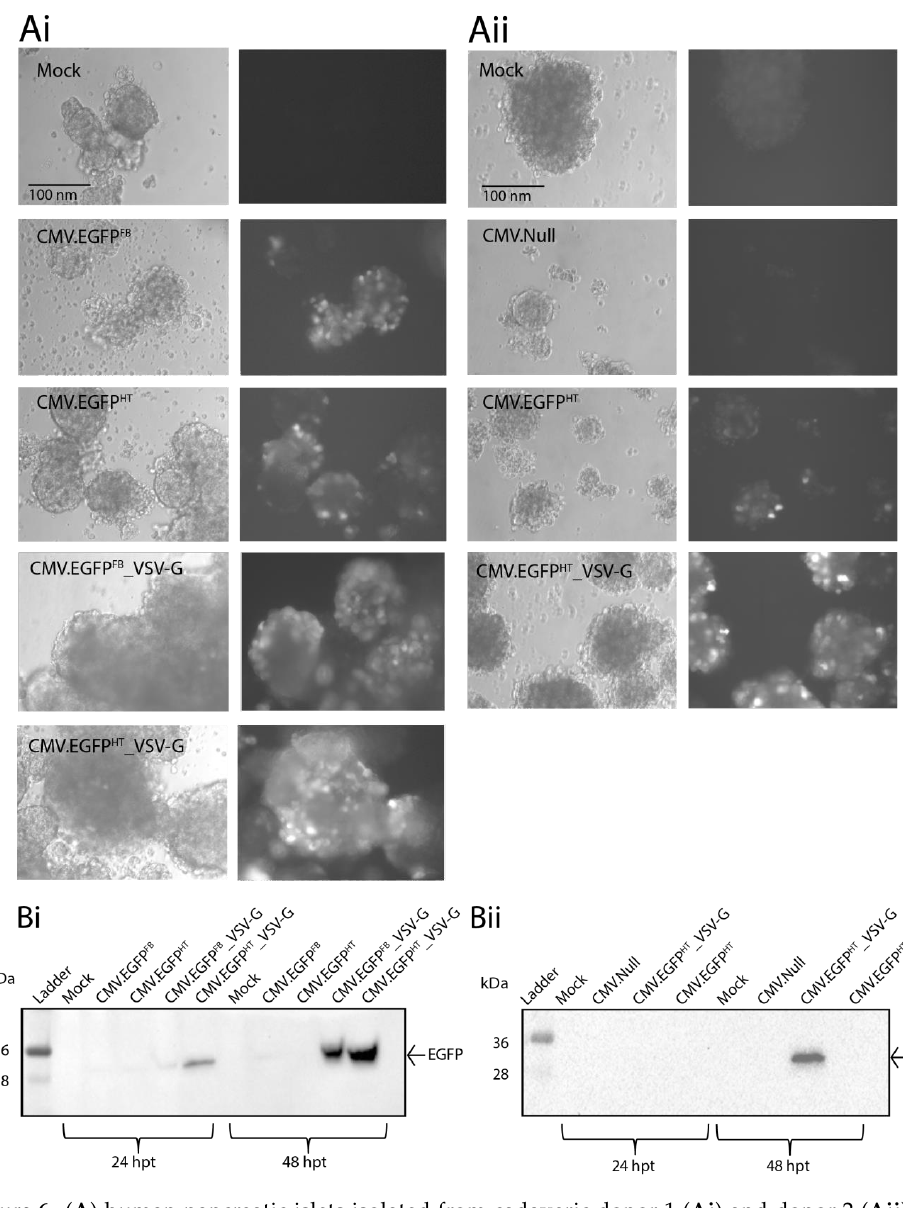
Figure 6. ( A ) human pancreatic islets isolated from cadaveric donor 1 ( Ai ) and donor 2 ( Aii ) were transduced with BacMam viruses at 250 MOI as shown. Bright field (left) and fluorescent (right) images were taken at 48 hpt using a Zeiss Axiovert 135 inverted epifluorescence microscope (×10). Scale bar, 100 nm. ( B ) Cell lysates were harvested from donor 1 ( Bi ) and donor 2 ( Bii ) at 24 and 48 hpt and were analysed by Western blotting using EGFP-specific antibodies. Molecular weight markers are in kDa.